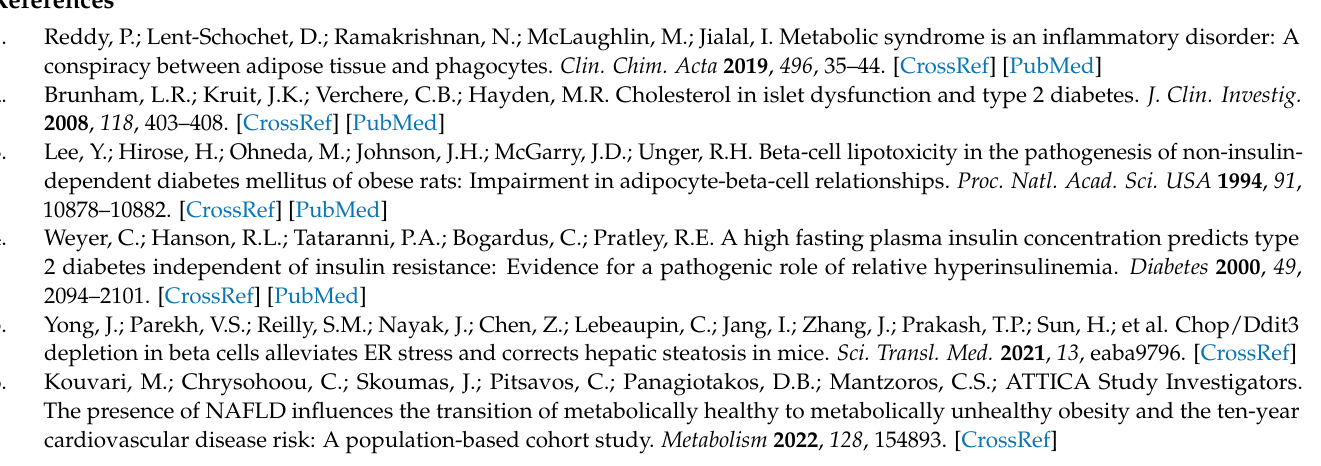
mentary Figure S2: Evaluation of protocols employed in cellular fractionation on Langerhans β -cell cultures. Supplementary Figure S3: LDL endocytosis in C9 cells (hepatocytes). Supplementary Figure S4: Characterization of endoplasmic reticulum isolates through the evaluation of protein markers PDI, SERCA2 under LDL treatment. Supplementary Figure S5: Auraptene (Aur) treatment (4–16 µ M) regulates the expression of cholesterol transporter ABCA1 in Langerhans β -cells. Supplementary Figure S6: VPS4 expression in Langerhans β -cells under LDL and auraptene (Aur) treatment. Sup- plementary Figure S7: Effect of LDL (20 µ g/mL) and insulin (Ins) (28 IU/L) on insulin signaling in hepatocyte